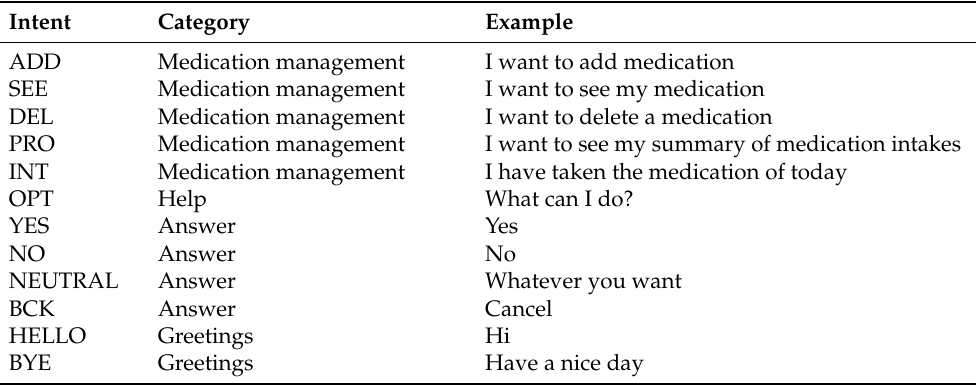
Table 2. Intent defined for the medication